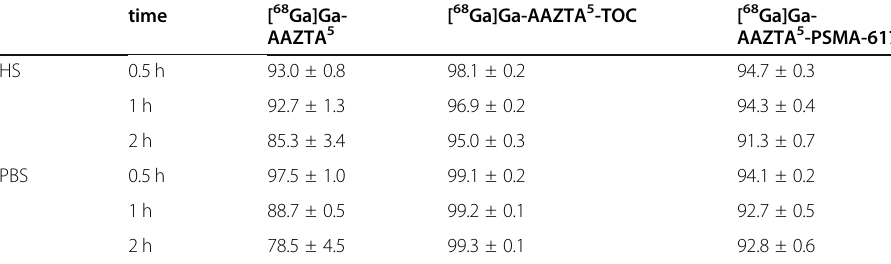
Table 2 Stability values of 68 Ga complexes of AAZTA 5 , AAZTA 5 -TOC and AAZTA 5